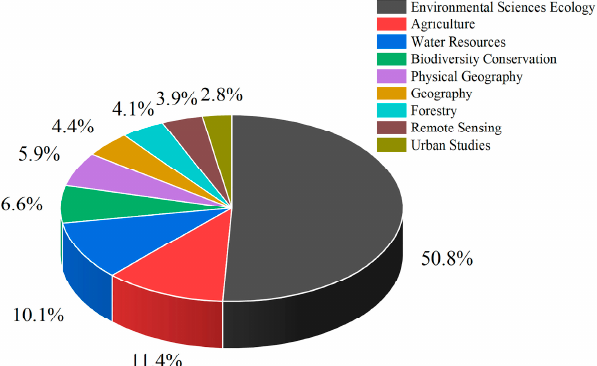
Figure 1. Classification of the articles reviewed in this study by field and their relative proportions.